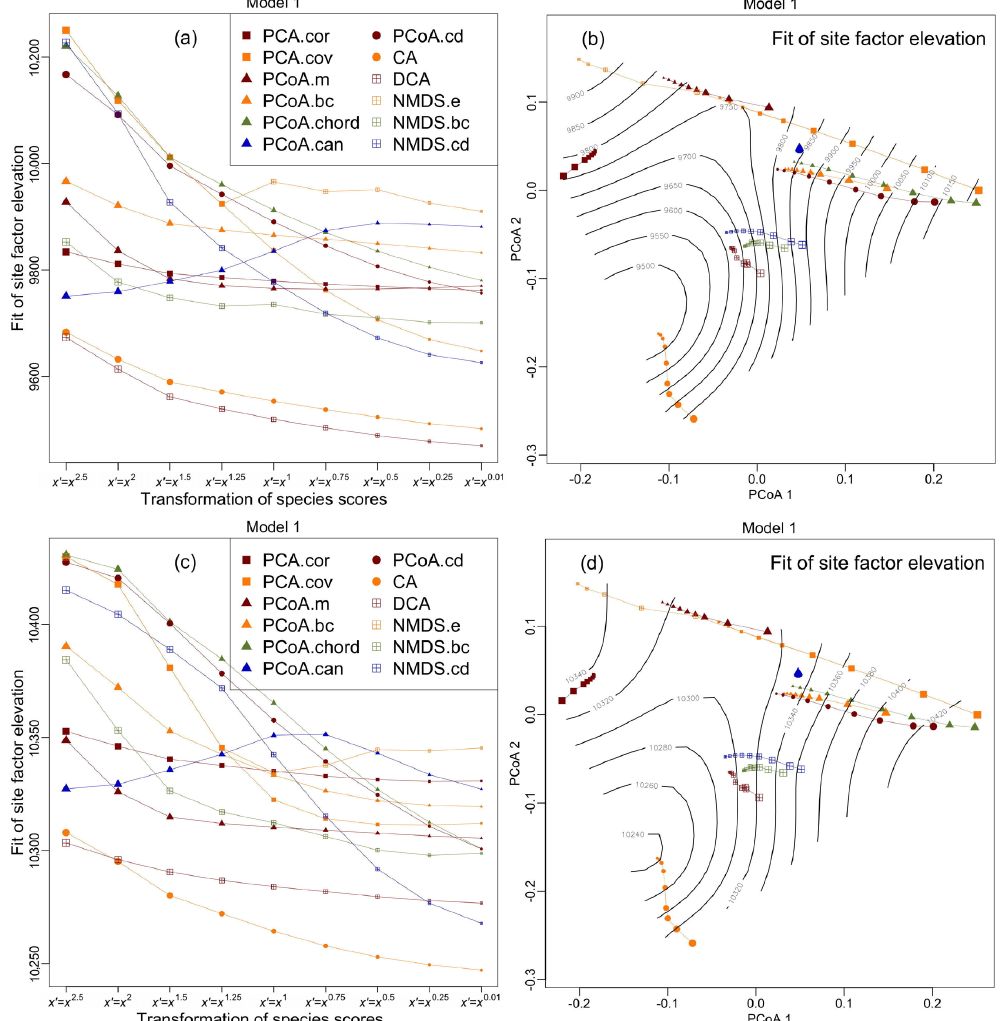
Figure 6. Measuring the efficiency of ordinations in explaining elevation ( a ) and precipitation ( c ) in the data sets “ws200” and “wssit”, respectively. The ordination of ordinations include trend surfaces from measuring the explanation power of elevation ( b ) and precipitation ( d ). Both are based on Mantel